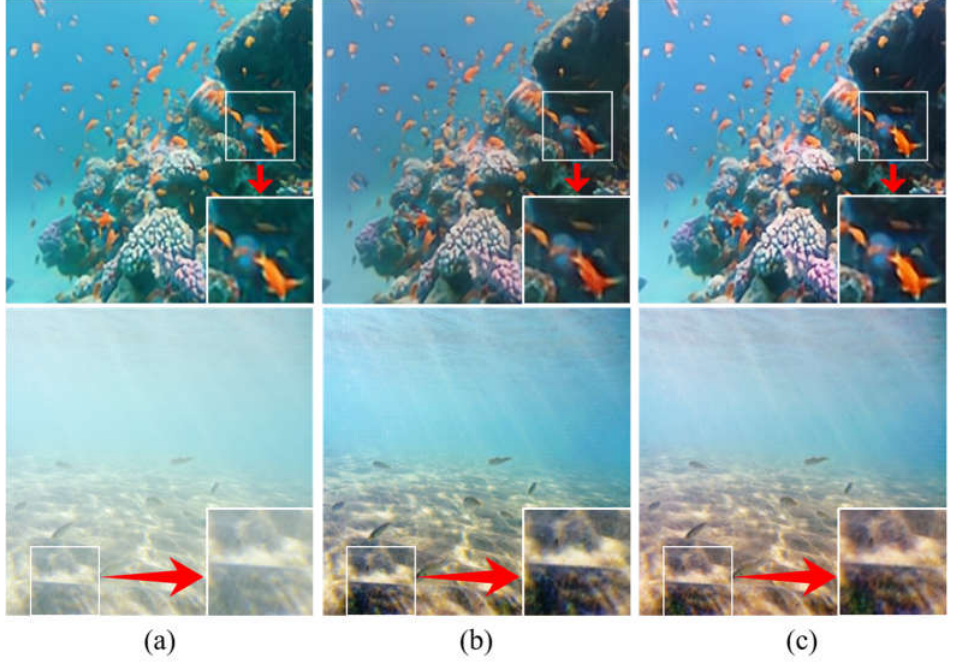
Figure 4. Visual comparison after adding the global–local discriminator. ( a ) Turbid underwater image. ( b ) Enhanced image after removing the global–local discriminator. ( c ) Enhanced image of UM- GAN. After adding the global–local discriminator, the local area detail enhancement is better, and the problem of insufficient local area enhancement is solved.